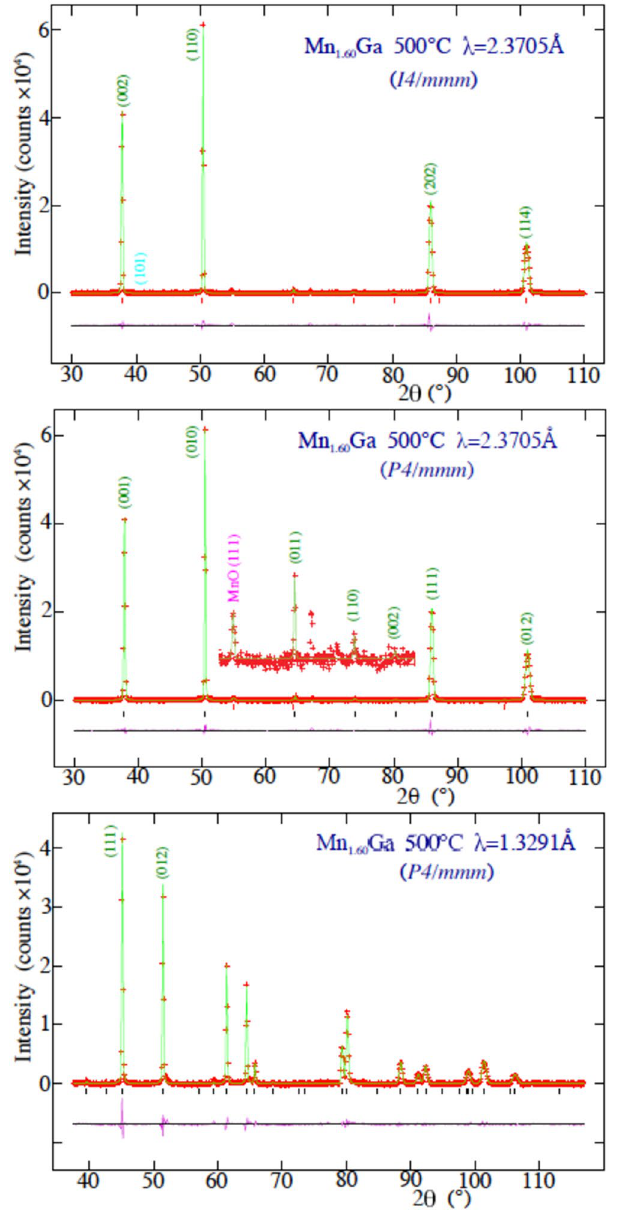
Figure 2. Neutron diffraction patterns for Mn 1.60 Ga taken at 500 °C ( i.e . above T C ). The top panel shows the pattern measured using 2.37047(8) Å neutrons and fitted assuming the I4/ mmm cell. The position of the (101) peak that would be present if the I4/ mmm cell were the correct choice and there was an imbalance in the Mn occupations of the two Ga sites is also shown (see text for more details). The middle and bottom panels show the data taken with 2.37047(8) Å and (bottom) 1.32905(5) Å neutrons respectively and fitted assuming the small P4/ mmm cell. The region between 2 θ = 52° and 2 θ = 82° has been rescaled by a factor of 20 in the centre panel so that the (111) peak from the 0.25(5) wt.% MnO impurity can bee seen. There is also a small peak from an unidentified impurity at 2 θ = 67.2°. The solid line in each case is a fit. Bragg markers and a plot of the residuals are also shown. Several Mn 1.60 Ga peaks in the 2.37047(8) Å patterns are indexed, as are the first two in the 1.32905(5) Å pattern (to establish the overlap between the two data